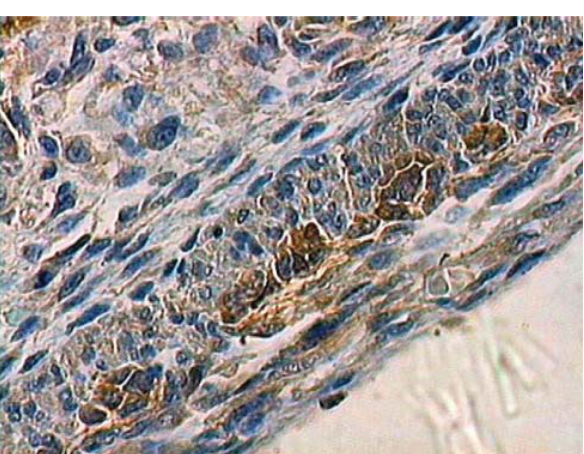
FIGURE 2 – Photomicrography of the terminal intestine of the internal control group with